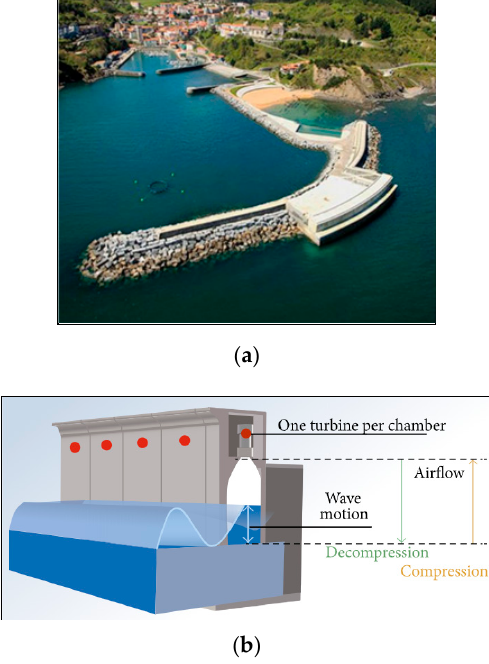
Figure 6. Mutriku generation plant [30]. ( a ) OWC Mutriku Power Plant. ( b ) System schematic.